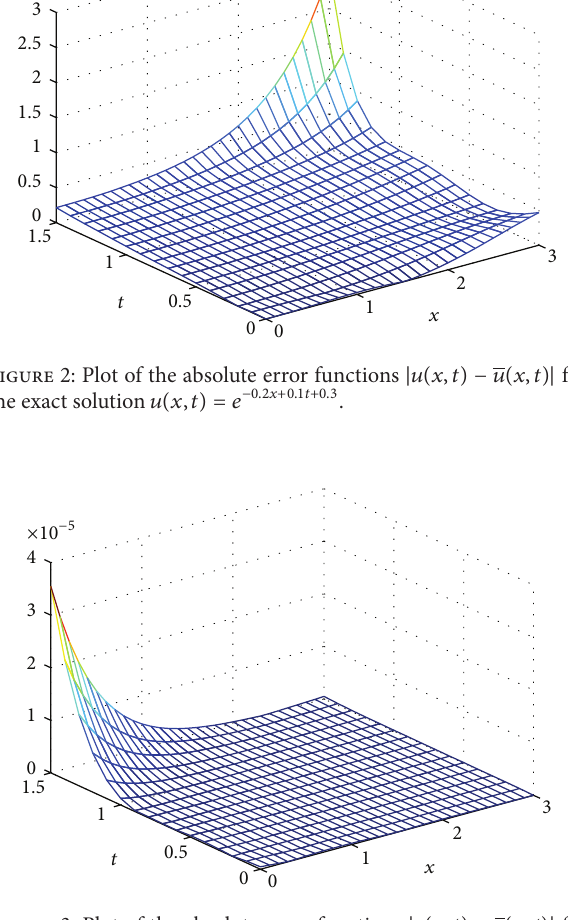
Figure 3: Plot of the absolute error functions | V (𝑥,𝑡) − V (𝑥,𝑡)| for the exact solution V (𝑥, 𝑡) = 𝑒 −0.4𝑥+0.2𝑡+0.6